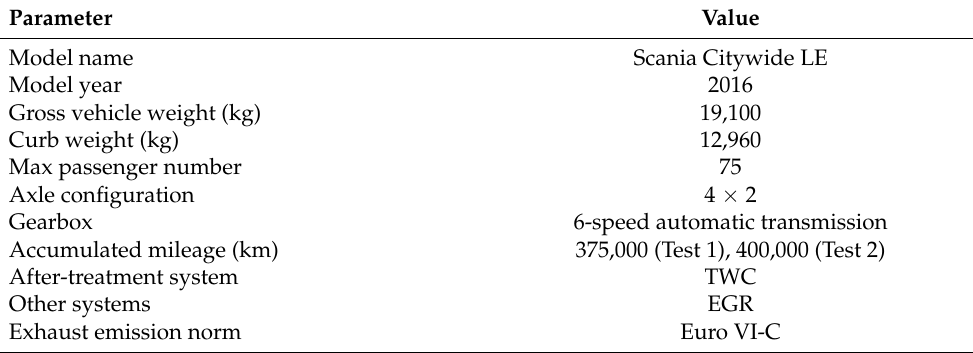
Table 1. Vehicle technical specifications.